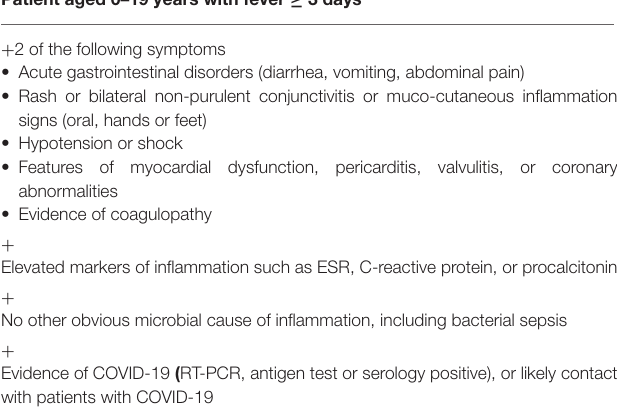
TABLE 1 | MIS-C criteria from the World Health